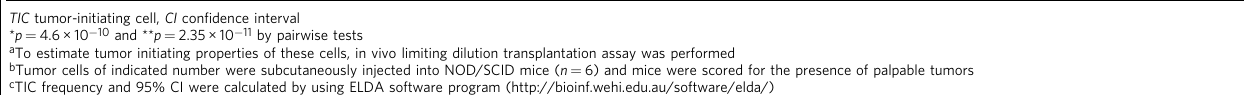
b Tumor cells of indicated number were subcutaneously injected into NOD/SCID mice ( n = 6) and mice were scored for the presence of palpable tumors c TIC frequency and 95% CI were calculated by using ELDA software program